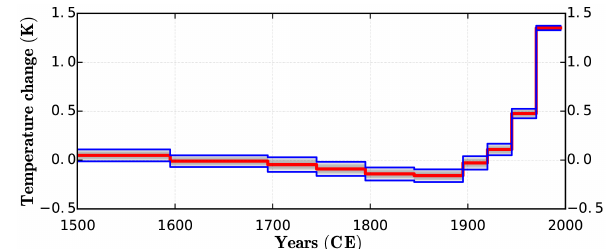
Figure 3. CA-9519 (Fox Mine, 1995) mean GST history (red) and 2 σ uncertainty intervals (blue) from the Monte Carlo inversion. The grey lines represent all the perturbed models within an interval de- termined by the RMS misfit from the SVD